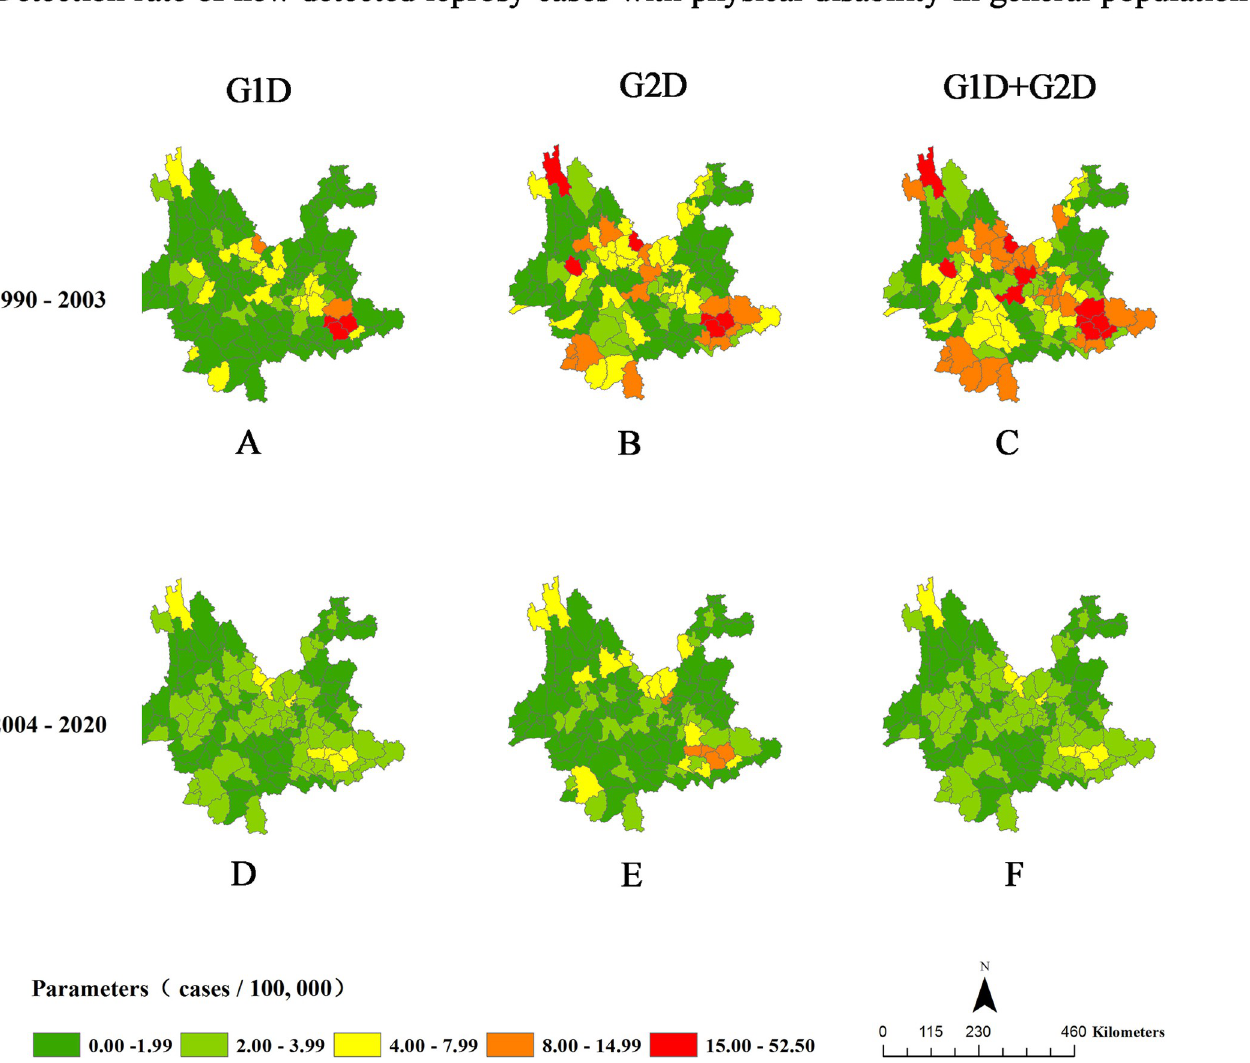
Fig 2. Proportions of Physical Disability Among Newly Detected Leprosy Cases in Yunnan, China, 1990–2020. The proportions of newly detected leprosy cases associated with G1D (A, D), G2D (B, E), and total physical disability (C, F) in the general population in time period 1 (1990–2003) (A, B, C) and time period 2 (2004–2020) (D, E, F). Map from Naive Map developed in AMAP with data from the National Catalogue Service For Geographic Information. https://